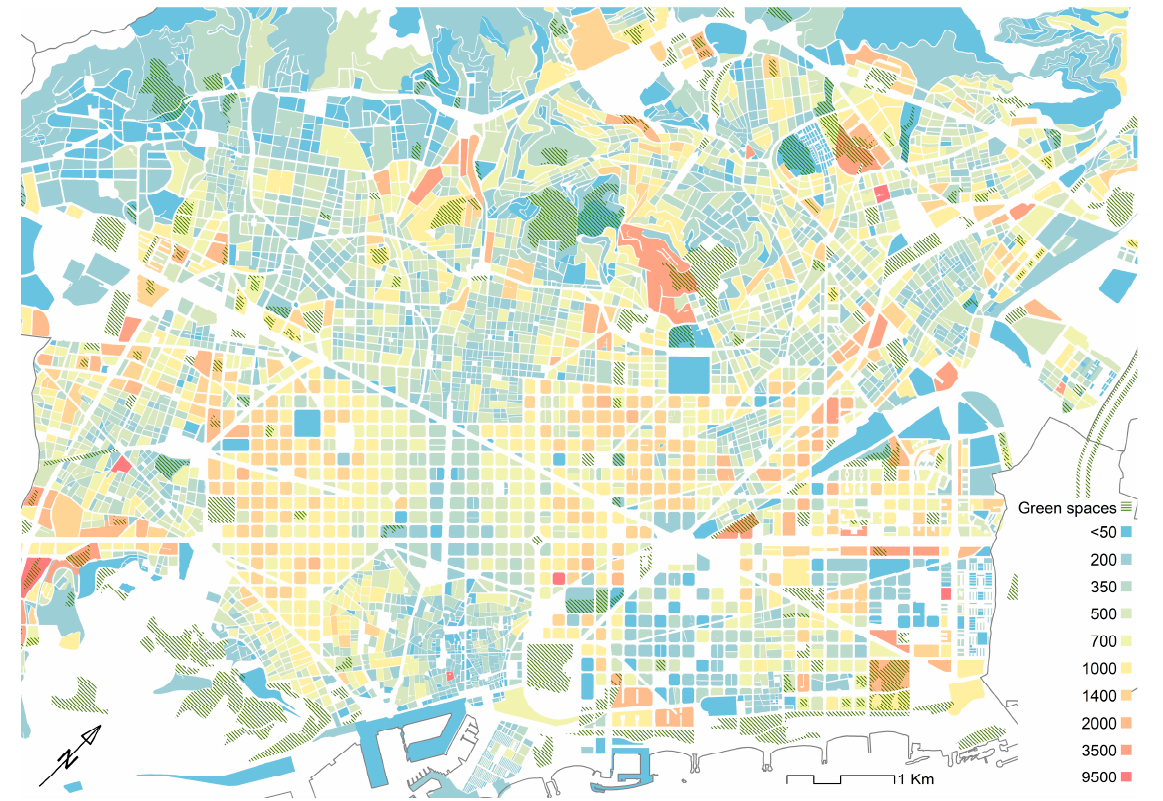
Figure 16. Number of inhabitants in Barcelona per block according to the census, and location of green areas of 0.5 hectare. Source: the authors based on data from Open Data BCN [57,62].